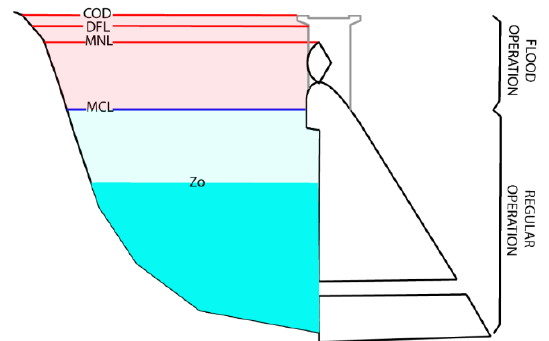
Figure 1. Conceptual scheme representing the role of maximum conservation levels (MCLs). COD represents the level of the crest of dam, DFL the design flood level, MNL the maximum normal operating level, and Zo the reservoir level prior to the flood event. Volume above MCL corresponds tothefloodcontroloperationvolumeandbelowMCLcorrespondstothewaterconservation operation